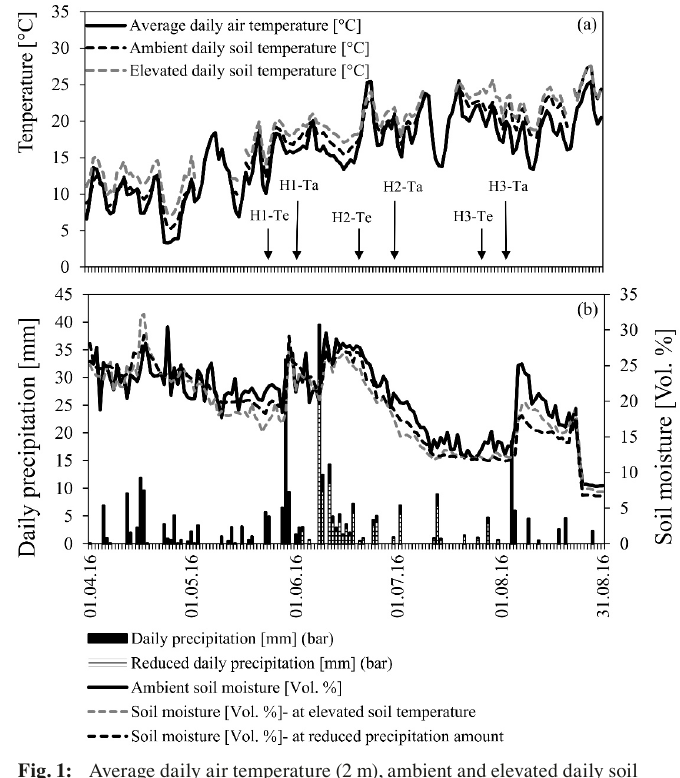
Fig. 1: Average daily air temperature (2 m), ambient and elevated daily soil temperature at the experimental site during the growing season from 01 April until 31 August 2016. Harvest dates are labelled as follows: H1: harvest 1 at stem elongation (DC 31); H2: harvest 2 at flowering (DC 65); H3: harvest 3 at maturity (DC 92); T a : ambient tempera- ture; T e : elevated temperature. The harvest of plants grown